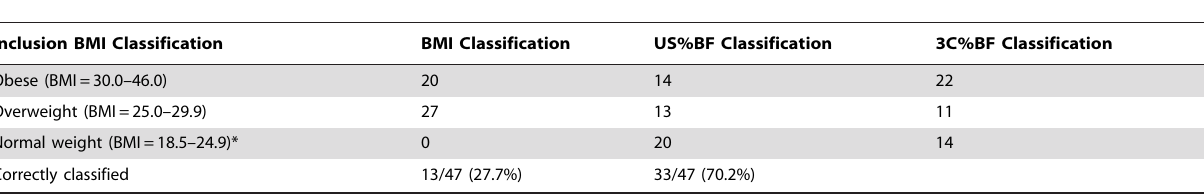
Table 4. Classification of ‘normal weight’ versus ‘overweight’ versus ‘obese’ for BMI and US, compared to the 3C %BF criterion.